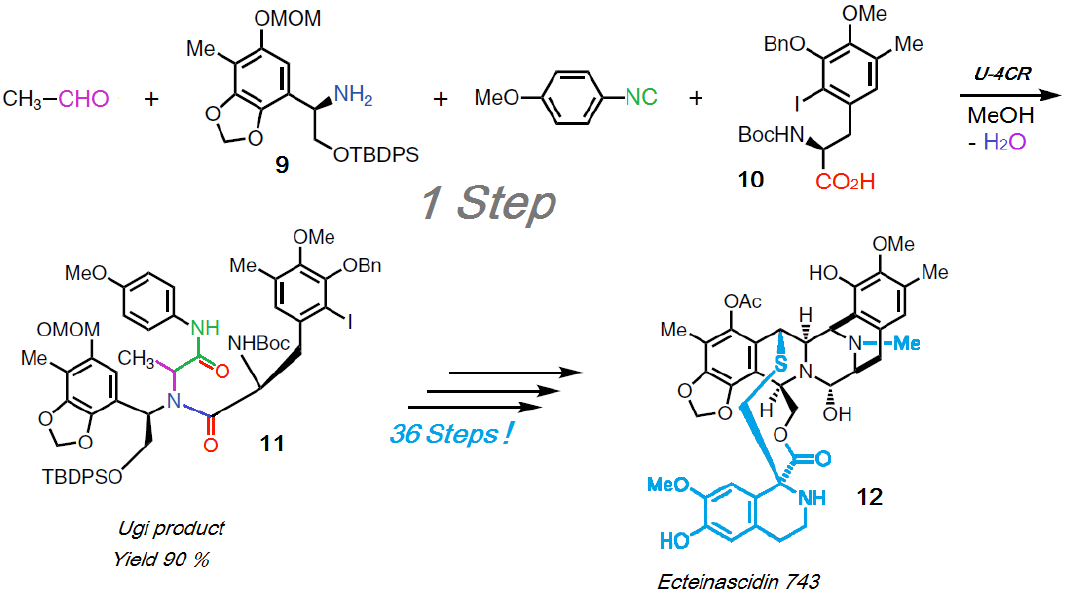
Scheme 13. Total synthesis of eicteinascidin 743.